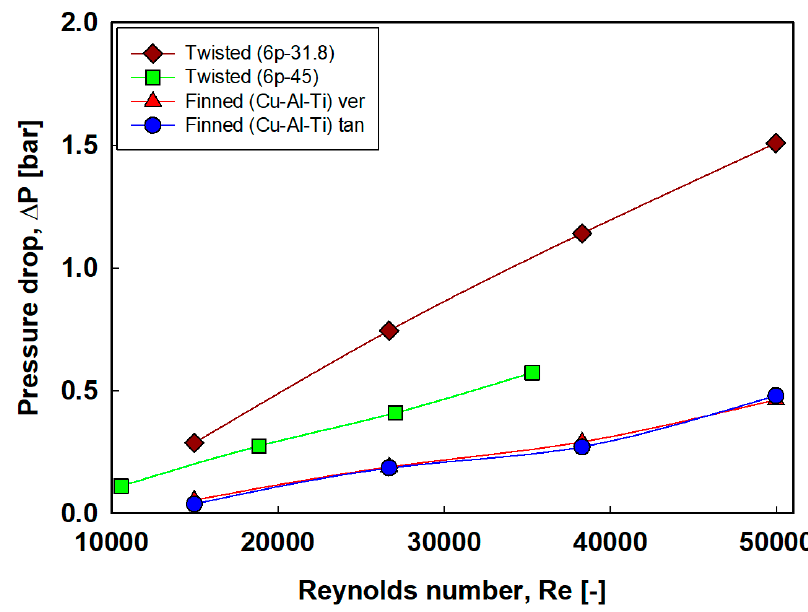
Figure 8. Water side pressure drops of various tubes according to Reynolds number.